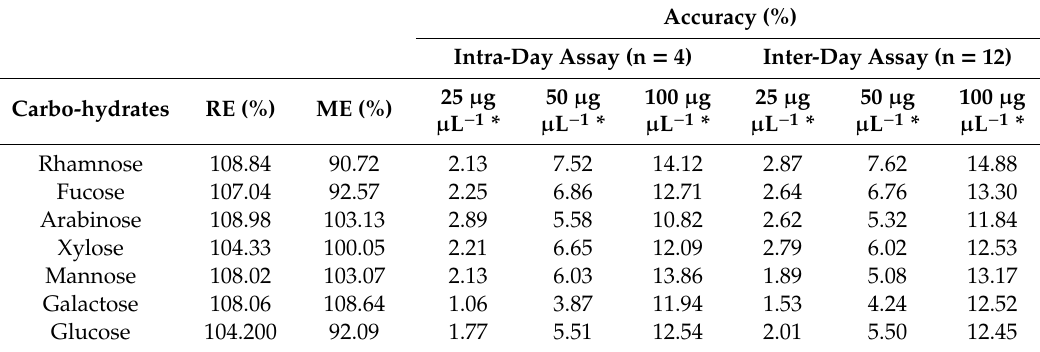
Table 4. Recovery (%), matrix e ff ect (%), intra- and inter-day accuracy (%) of the matrix polysaccharide. Accuracy (%) Intra-Day Assay (n = 4)